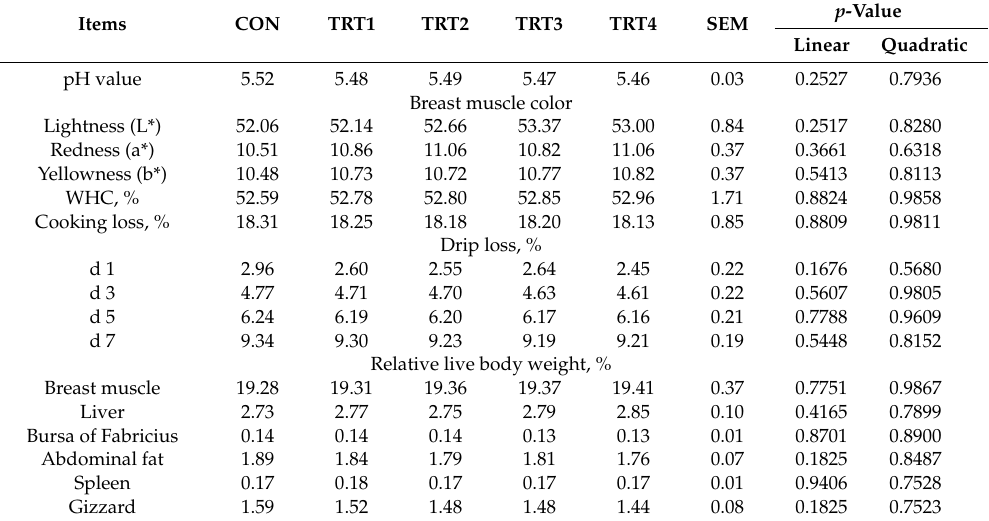
Table 4. E ff ect of coating the blend of OA and MCFA supplementation on meat quality in broilers.